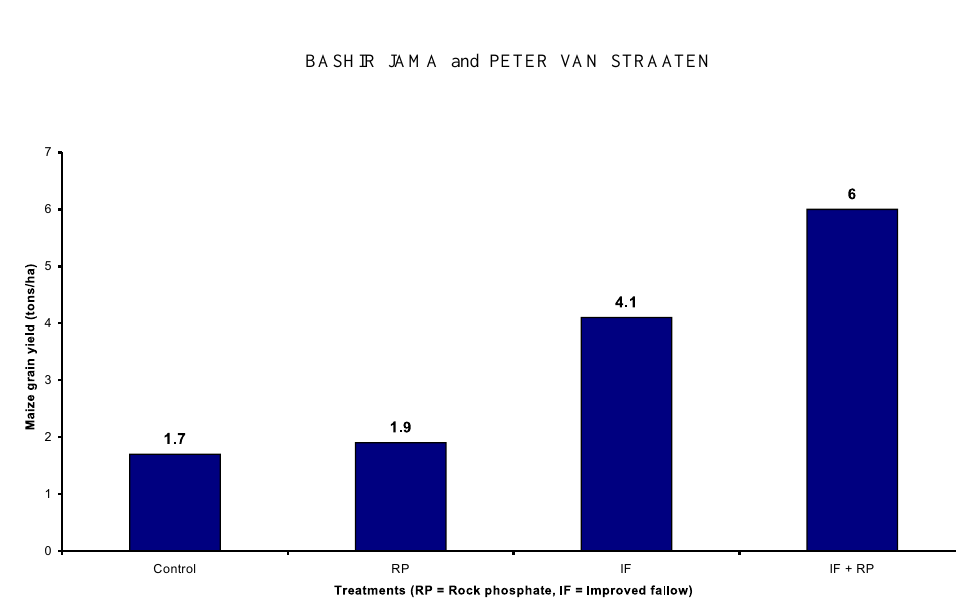
Fig. 3 – Effect of improved fallows and Minjingu phosphate rock on maize grain yield under a case study of 83 farmers in western Kenya (Source: Bashir Jama, unpublished